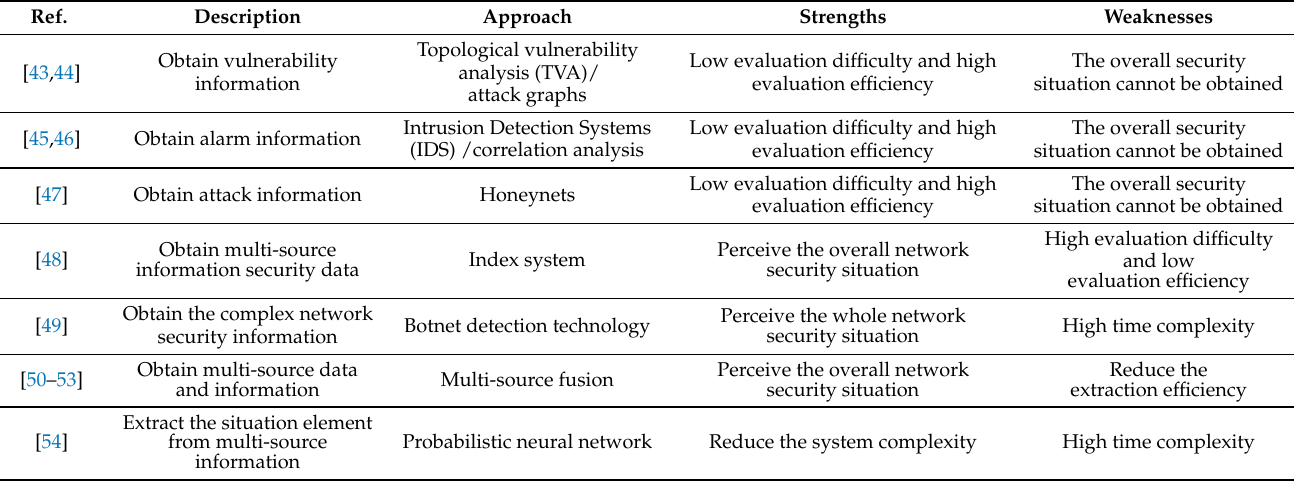
Table 2. Network security situation elements